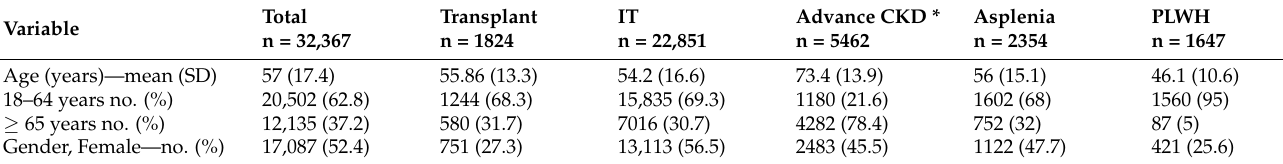
Table 1. Baseline characteristics of immune-compromised patient in the registry, October